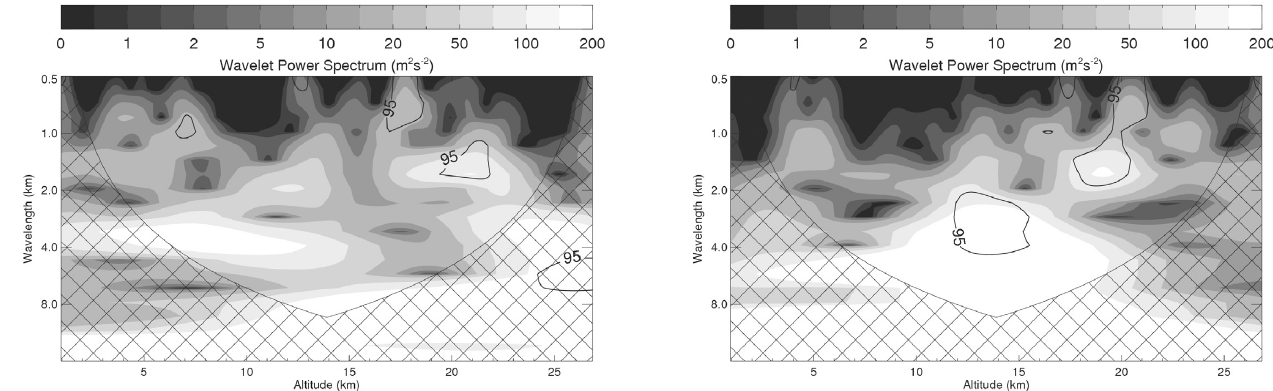
Fig. 9. Case 2: Salta radiosounding. Morlet wavelet analysis of the splined vertical velocity profiles by Torrence and Compo (1998) method. Power spectrum (m 2 s − 2 ) with level of significance above 95% for dominant wavelengths and their locations. Hashed regions are out of the cone-of-significance, and should not be taken into account. Left: Zonal wind. Right: Meridional wind.